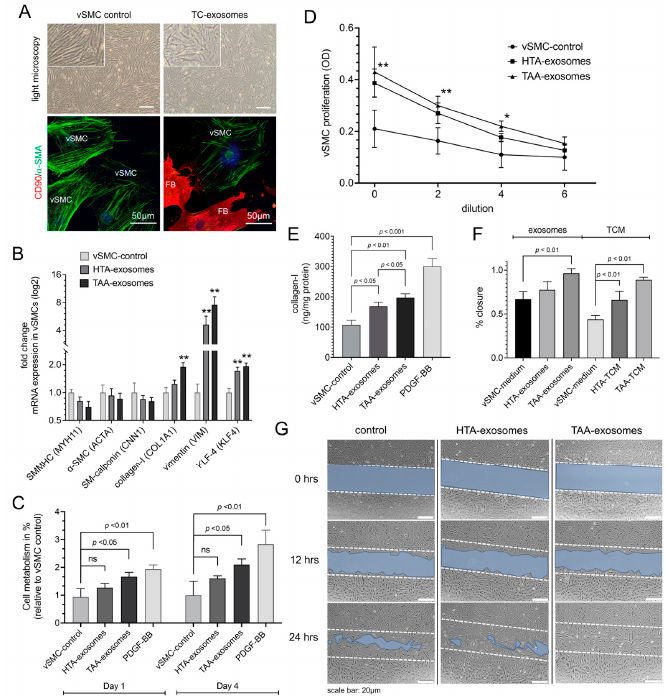
Figure 3 . Effect of exosomes isolated from aneurysmal telocytes (TCs) on proliferation, metabolism, and phenotype specific mRNA expression of aortic vascular smooth muscle cell (vSMC)-cell culture. Exosomes were isolated from isolated TCs from healthy aortic tissue (HTA, n = 10) or thoracic ascending aneurysm (TAA, n = 10). ( A ) Morphological changes shown by light microscopy and α -SMA reengagement by immunofluorescence in SMCs treated with TC-exosomes compared to SMC control in isolated aortic cell culture containing vSMCs and fibroblasts (FB). CD90 (FB-marker), red; α -SMA (vSMC-marker), green; DAPI (cell nucleus), blue. Scale bar of light microscopy 20 µ m. ( B ) Quantitative RT-PCR of SMC-phenotype specific mRNA expression after HTA-exosomes or TAA- exosomes compared to vSMC-control. Synthetic phenotype mRNA expression ( COL1A1 , VIM , and KLF4 ) were increased, whereby contractile phenotype mRNA expression ( MYH11 , ACTA , and CNN1 ) showed no differences after treatment with TAA-exosomes. Bars indicate the relative expression of each mRNA normalized to GAPDH and RPLP0 . Data are mean ± SD of two independent experiments. **, p < 0.01. ( C ) Effect of HTA- and TAA-exosomes compared to vSMC-control tested in aortic vSMCs by MTT assay after 1 and 4 days of treatment. PDGF-BB treatment was used as positive control. ns, non-significant. Data are mean ± SD of four independent experiments. ( D ) Dilution-depended exosome-induced cell proliferation tested in aortic SMCs. OD values resulting from CCK-8 assay, HTA- and TAA-exosomes were compared to vSMC control. OD, optical density. Data are mean ± SD of four independent experiments. *, p < 0.05; **, p < 0.01. ( E ) Collagen-I measurements after different exosome or control treatments after 3 days tested in vSMCs with PDGF-BB as positive control. Data are mean ± SD of three independent experiments. ( F , G ) Cell migration (scratch wound healing assay). ( F ) Values of percentage wound closure ± SEM ( n = 3). Different exosome treatment or TC-conditioned medium (TCM) treatment were compared to vSMC medium as control group 24 h after treatment start. ( G ) Representative images are shown from three independent experiments at time points beginning (0 h), 12 h, or 24 h. Blue area defines the areas lacking cells, initial scratch line shown by dashed lines (wound area, ImageJ). Scale bar, 20 µ